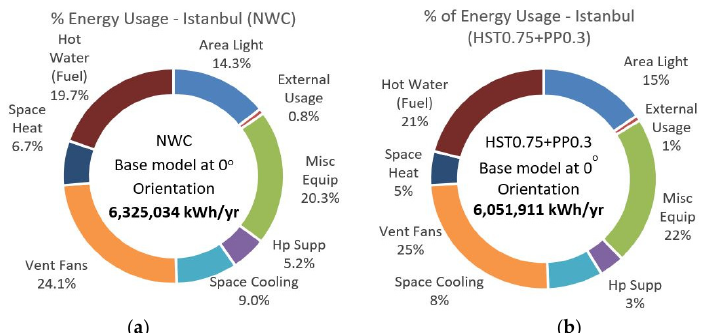
Figure 8. Percentage breakdown of annual energy consumption end-use comparison for Istanbul: ( a ) NWC; ( b ) HST0.75 + PP0.3.